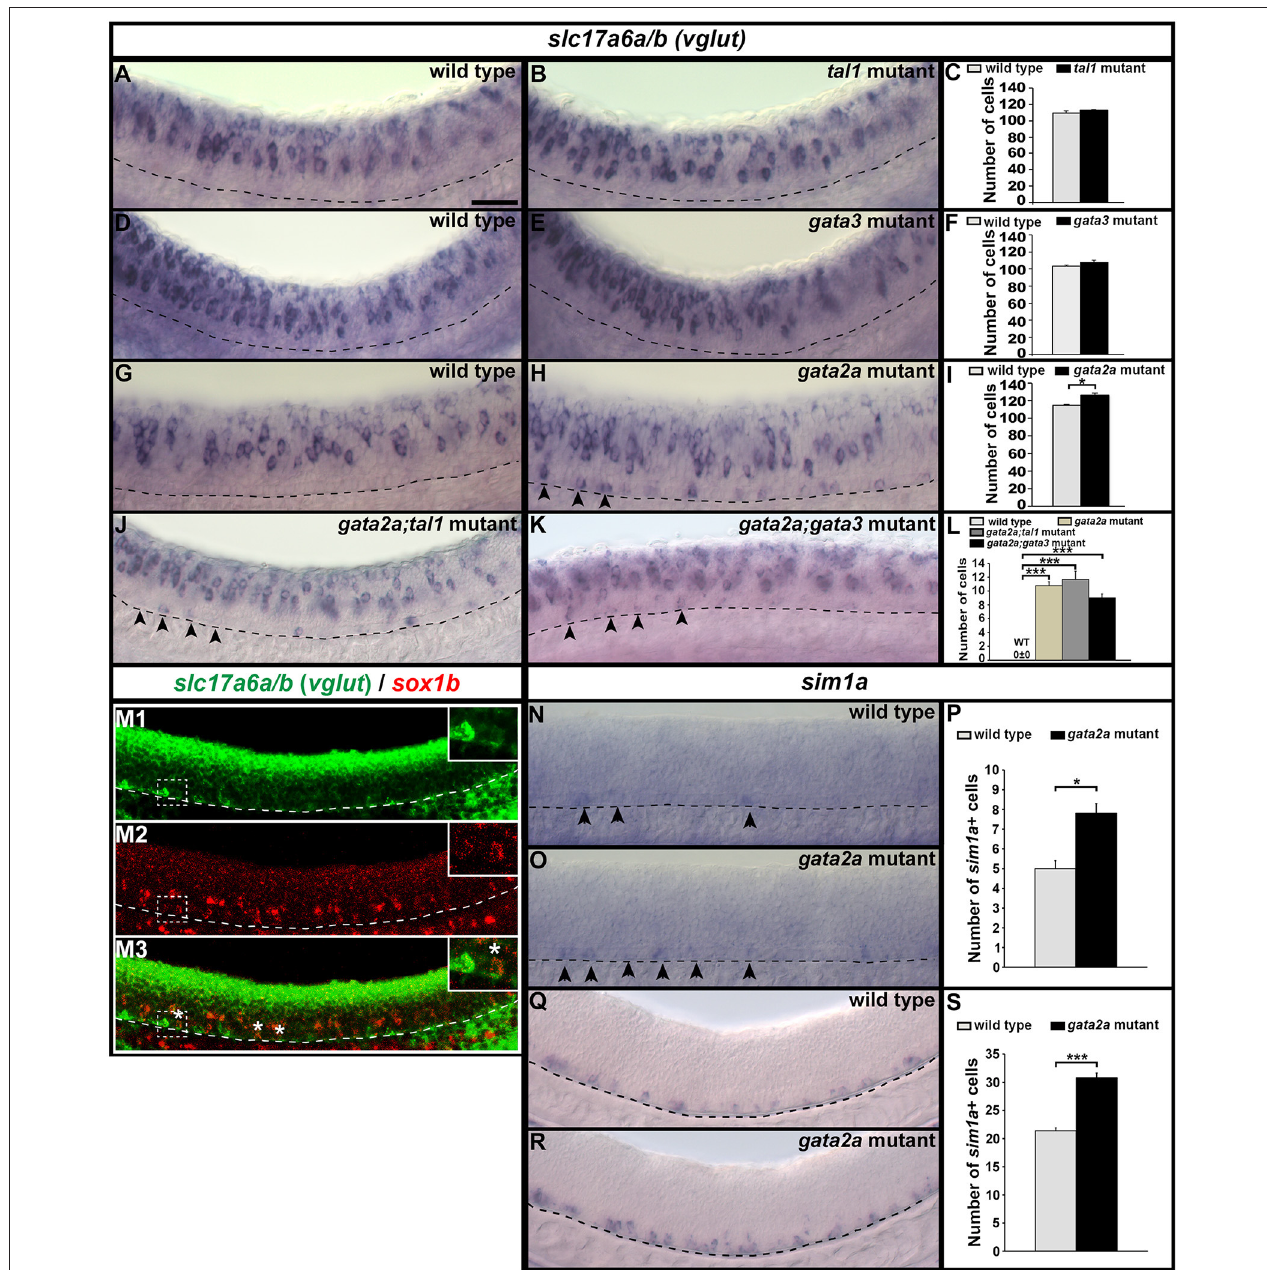
FIGURE 11 | Expression of slc17a6a/b and sim1a in mutant embryos. Lateral views of slc17a6a/b (vglut) (A,B,D,E,G,H,J,K) , slc17a6a/b (green) and sox1b (red) (M), and sim1a (N,O,Q,R) expression in WT sibling and mutant embryos as indicated. Dorsal, top; anterior, left. All embryos are 24h except (M,Q,R) , which are 32h. Arrowheads indicate glutamatergic cells (H,J,K) or sim1a -expressing cells (N,O) in the KA ′′ region. Scale bar = 50 microns. Dashed lines indicate ventral limit of spinal cord. White boxes in (M) are single confocal magnified views of dotted white box. White stars indicate double-labeled cells. Mean number of cells expressing these genes in spinal cord region adjacent to somites 6–10 in WT and mutant embryos (C,F,I,L,P,S) . Panels (C,F,I,P,S) show counts for all dorsal-ventral rows. Panel (L) shows counts for just row 1 and hence, the value for WT embryos is zero. All counts are an average of at least 4 embryos. Error bars indicate SEM. Statistically significant comparisons are indicated with brackets and stars. *** P < 0.001, * P < 0.05. For P- values see Supplementary Table 6.